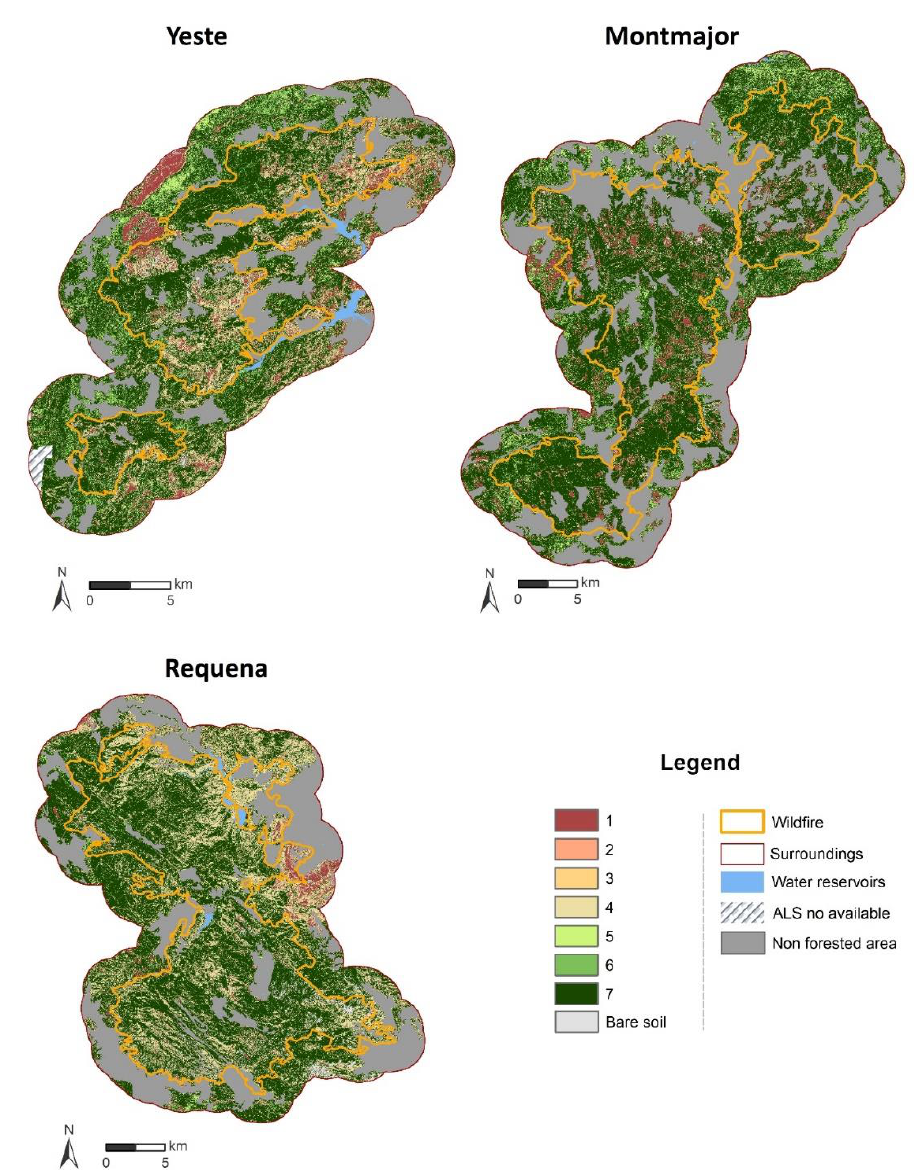
Figure 3. Fuel type classification mapping using SVM with radial kernel within the forested areas under study.